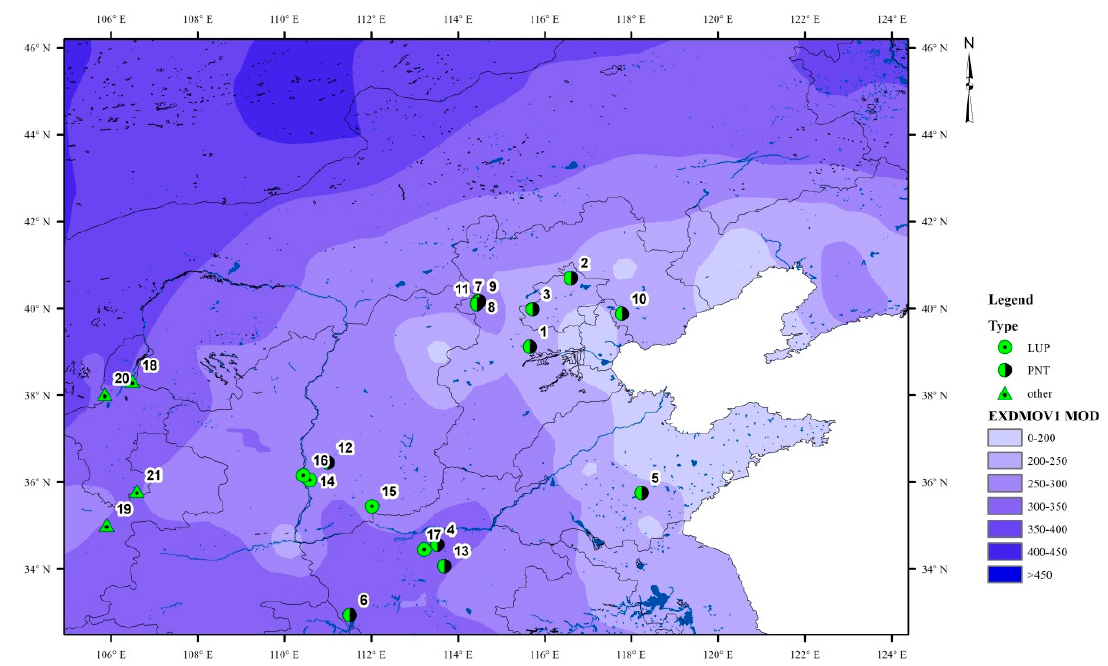
Figure 9. Archaeological sites dated to the Pleistocene to Holocene transition on the maps of expected distance of residential movement per year of hunter–gatherers (EXDMOV1) in northern China under LGM and modern climatic conditions.